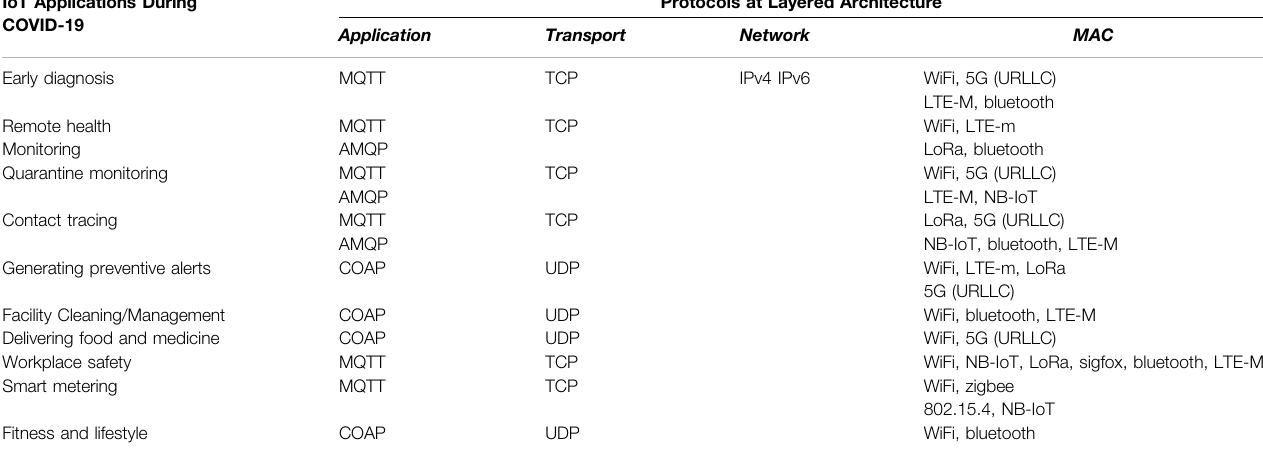
TABLE 2 | Proposed Protocols for IoT Layered Architecture. IoT Applications During